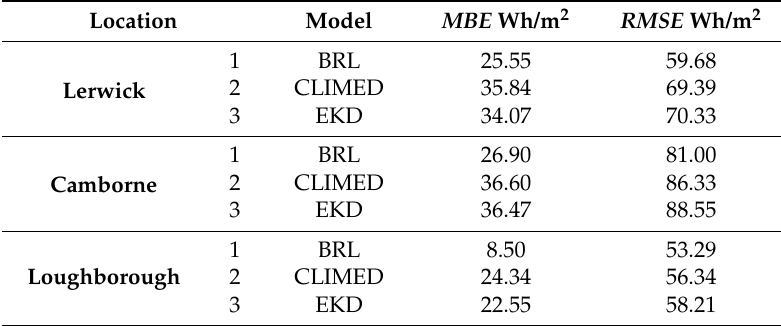
Table 4. Mean bias error ( MBE ) and root mean square error ( RMSE ) between modelled global horizontal diffuse and World Radiation Data Centre (WRDC)/Loughborough measured value. BRL: Boland, Ridley, Lauret; CLIMED: Climatic Synthetic Time Series for the Mediterranean Belt; and EKD: Erbs, Klein,